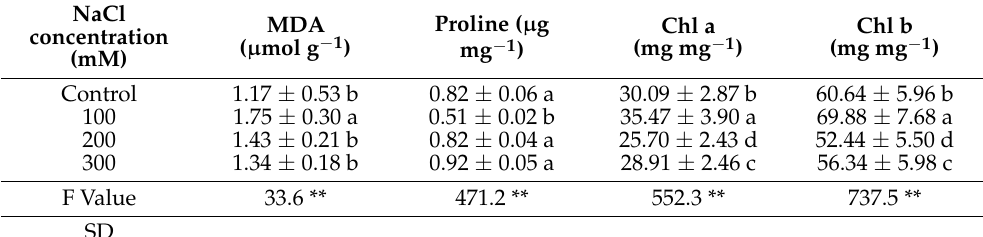
Table 5. Mean effect of the salt stress level (0, 100, 200 and 300 mM NaCl) on the content of malondialdehyde (MDA), free proline and chlorophyll a and b (mean ± SD), regardless of the pumpkin accession.